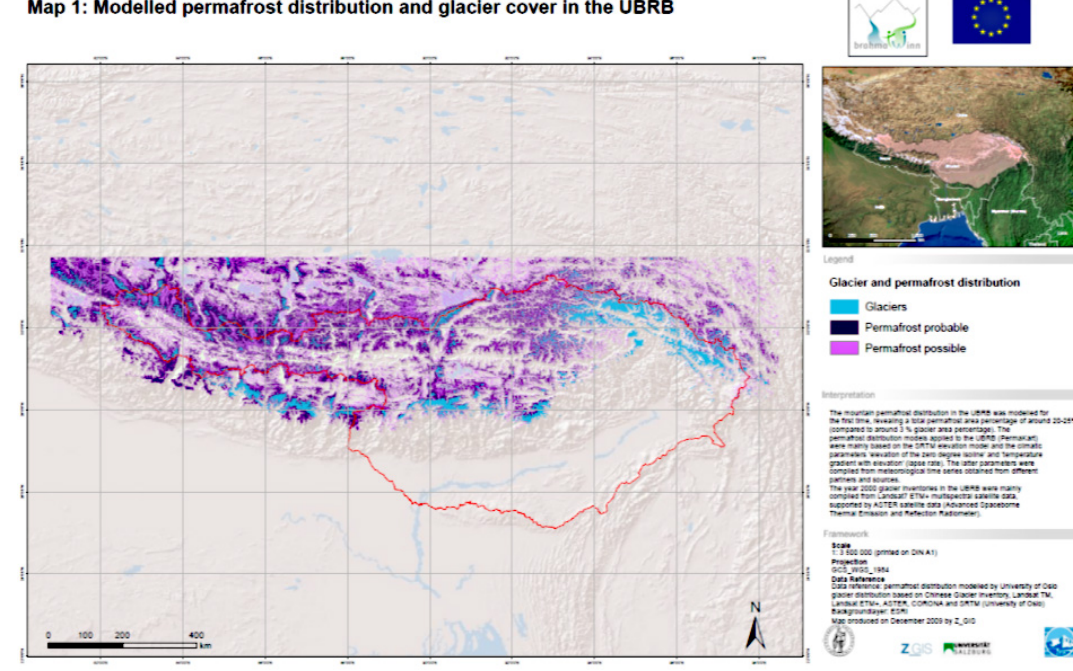
Figure 3. Glacier and permafrost distribution in the